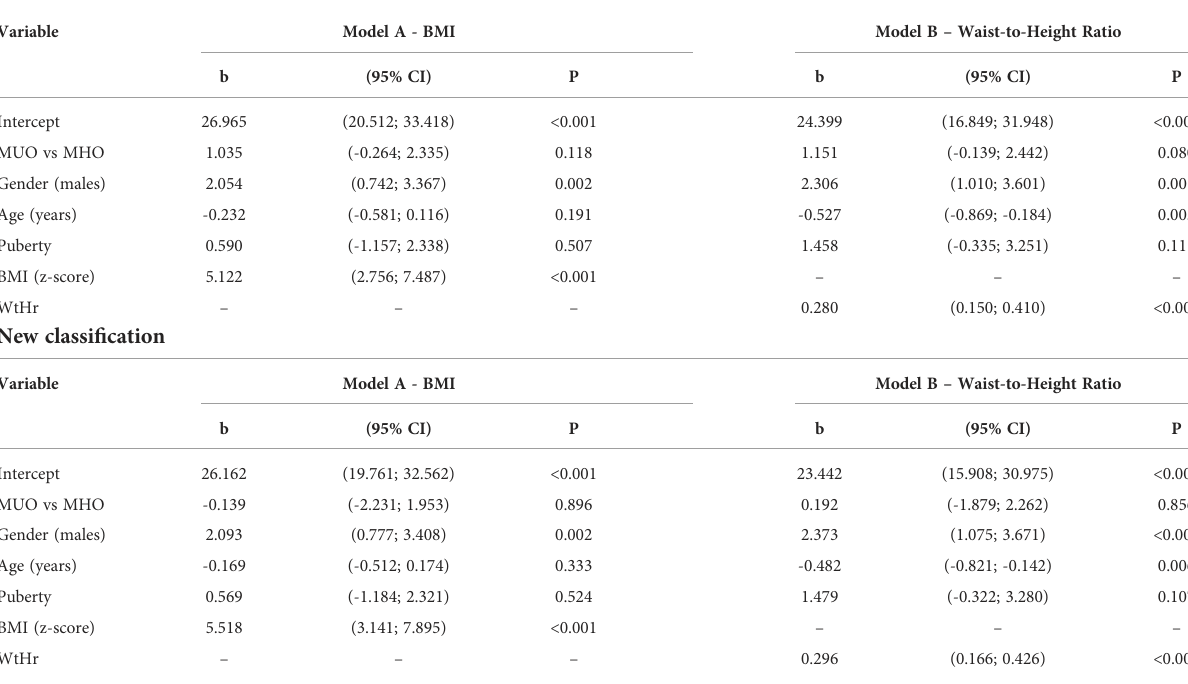
TABLE 2 Effect of metabolically unhealthy obese phenotype, gender, age, puberty, BMI (Model A) or waist-to-height ratio (Model B) on left ventricular mass index by a multiple linear regression model. Standard classi fi cation